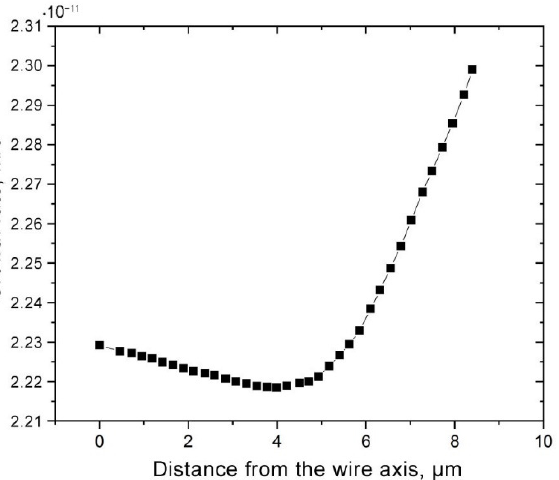
Figure 4. Distribution of nanocrystal growth rate over the microwire radius calculated by the Formula (7).